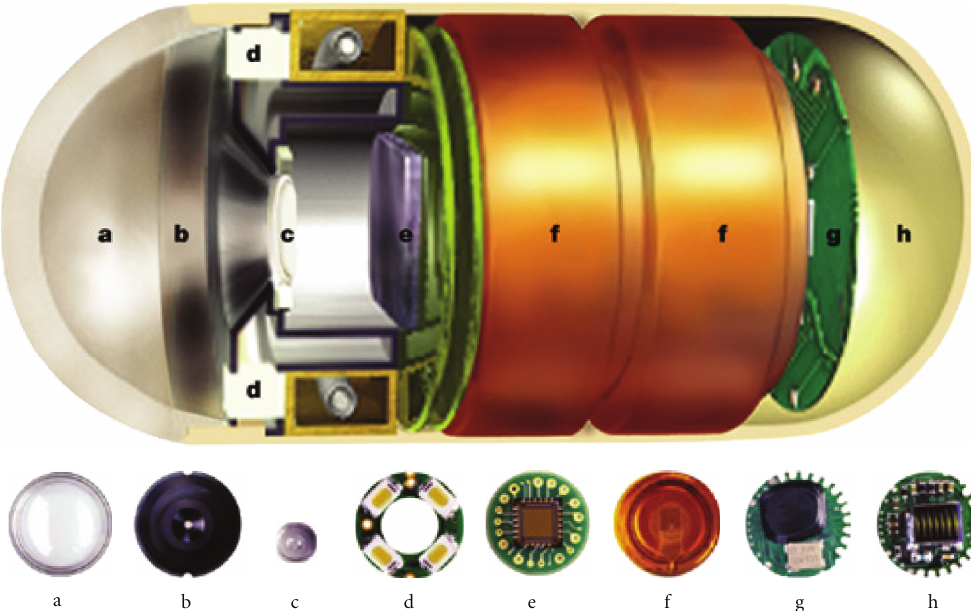
Figure 4: The M2A capsule camera. The device consists of a disposable plastic capsule that weighs 3.7 grams and measures 11mm in diameter by 26 mm in length. The contents include an optical dome (a), a lens holder (b), a short focal-length lens (c), six white-light-emitting diode illumination sources (d), complementary metal oxide silicon (CMOS) chip camera (e), two silver oxide batteries (f), a UHF band radio telemetry transmitter (g), and an antenna (h) (published with permission from